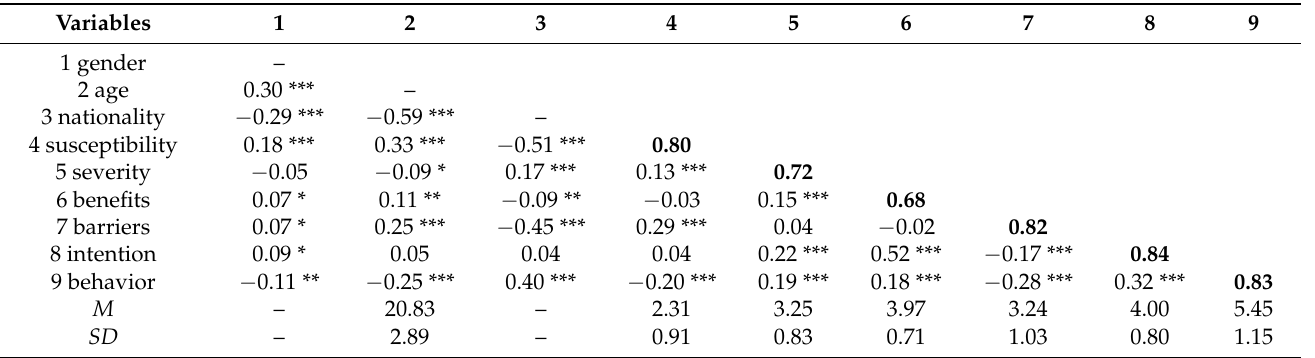
Table 3. Means, standard deviations, and